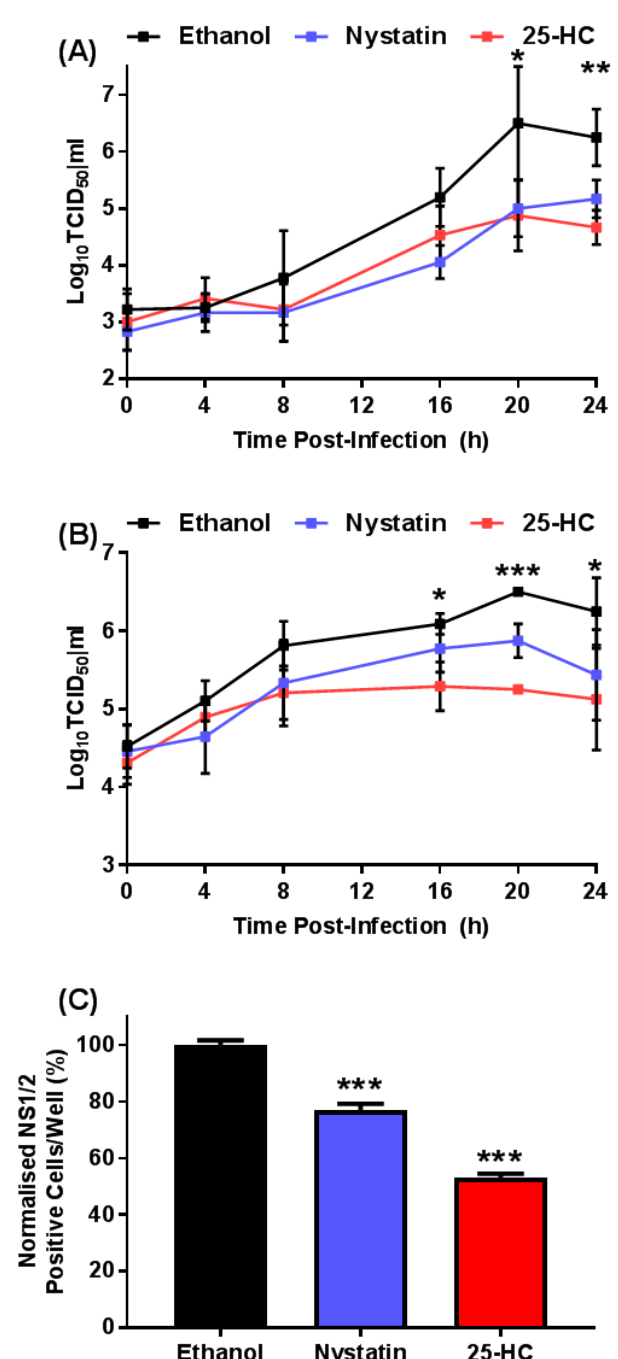
Figure 2. The oxysterol, 25-HC, reduced the titer of MNV. RAW264.7 were infected with MNV at a MOI of approximately ( A ) 0.05 TCID 50 /cell or ( B ) 5 TCID 50 /cell and immediately treated with 25-HC (6.6 µ M), nystatin (50 µ M) or ethanol-only control. At regular intervals, replicate wells were harvested, supernatant clarified by centrifugation and virus titer determined by TCID 50 assay. Data show mean virus titer ( n = 3 ± SEM, * = p < 0.05, ** = p < 0.01, *** = p < 0.001). ( C ) RAW264.7 cells were infected with MNV and immediately treated with 25-HC (6.6 µ M), nystatin (50 µ M) or ethanol-only control. At 12 h post-infection, the expression of MNV NS1/2 protein was detected by indirect immunofluorescence and the number of virus positive cells was quantified using an IncuCyte ZOOM FLR. Data show the mean number of virus-infected cells per well and statistical analysis compared to ethanol-only control ( n = 3 ± SEM, *** = p < 0.001).